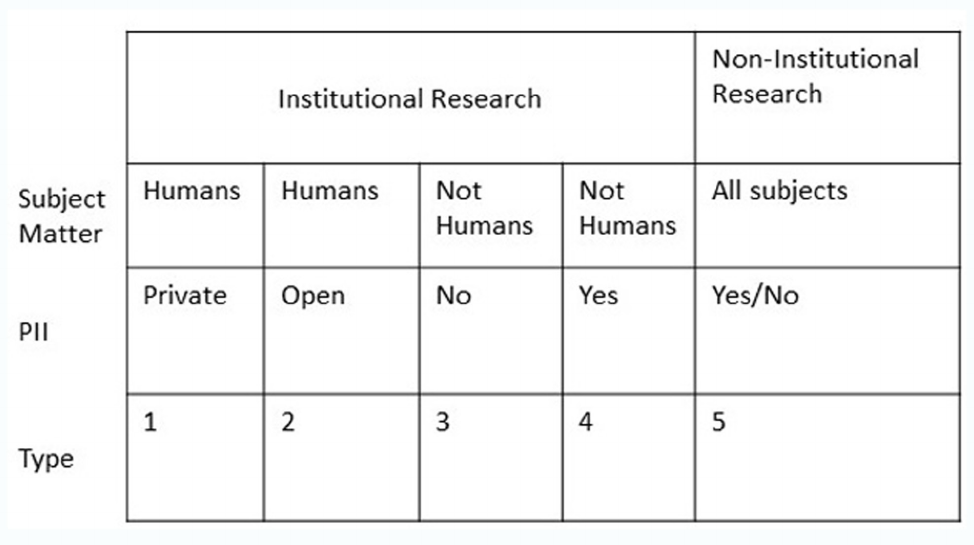
Figure 1: Categories of citizen science projects. We categorized projects through several levels, first based on whether they are institutional research, second on whether the subject matter was human subjects or other subjects, and third related to the handling of personally identifiable information